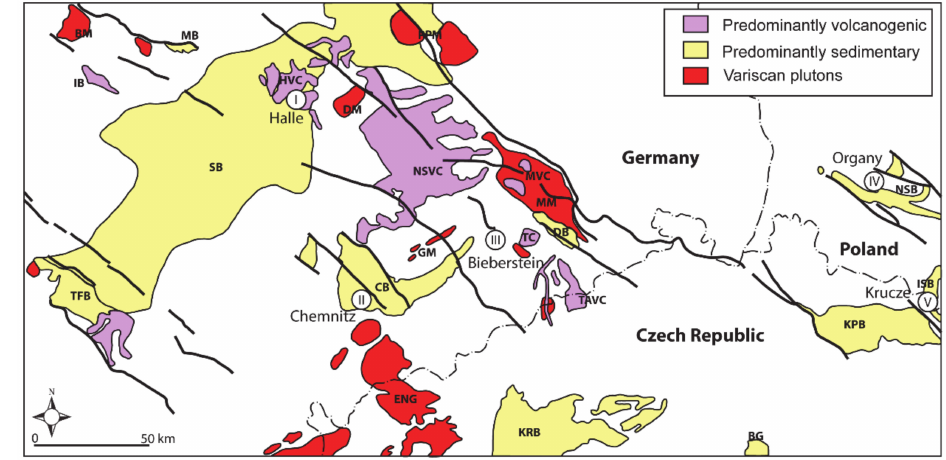
Figure 1. Distribution of Permo-Carboniferous volcanic rocks in Central Europe. Sampling